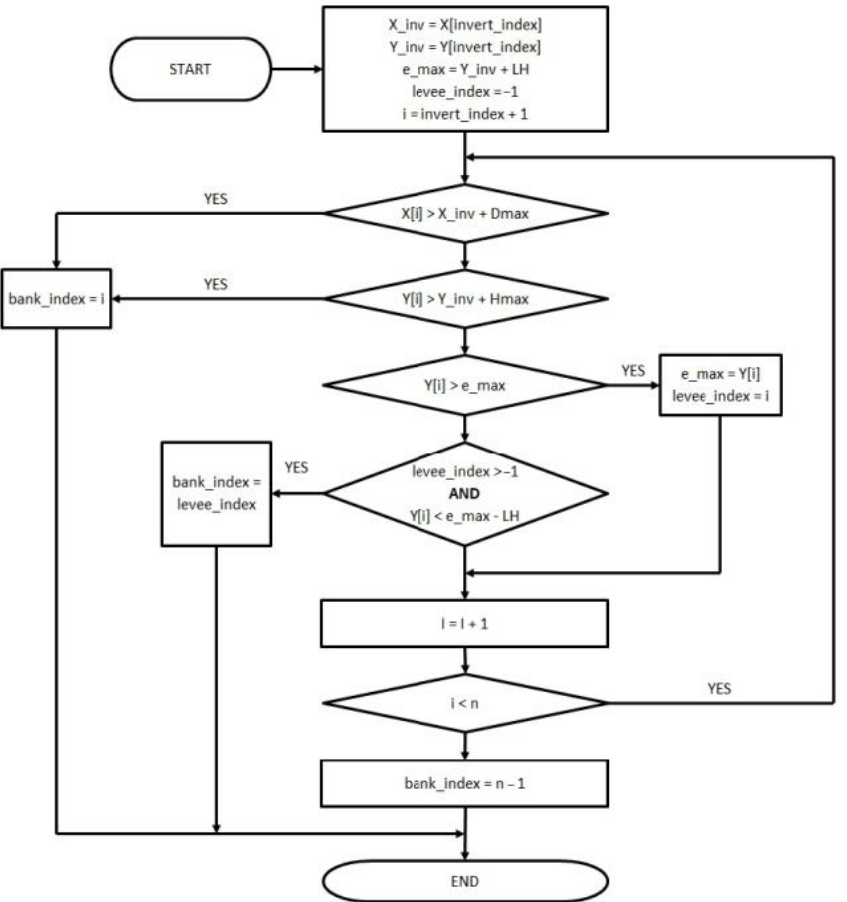
Figure 15. Logic diagram of the bank detection algorithm.